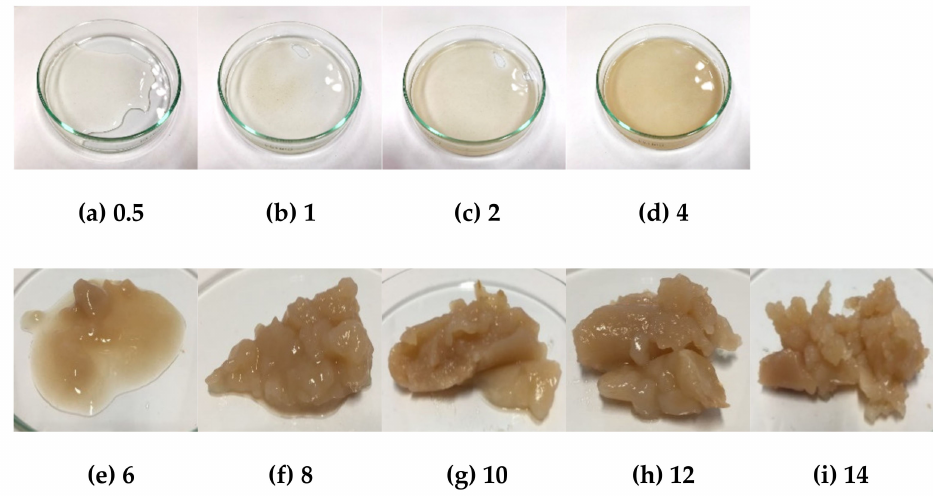
Figure 6. Gelation of NW banana starch at 80 ◦ C at different concentrations where ( a ) 0.5% w / v , ( b ) 1% w / v , ( c ) 2% w / v , ( d ) 4% w / v , ( e ) 6% w / v , ( f ) 8% w / v , ( g ) 10% w / v , ( h ) 12% w / v , and ( i ) 14% w / v